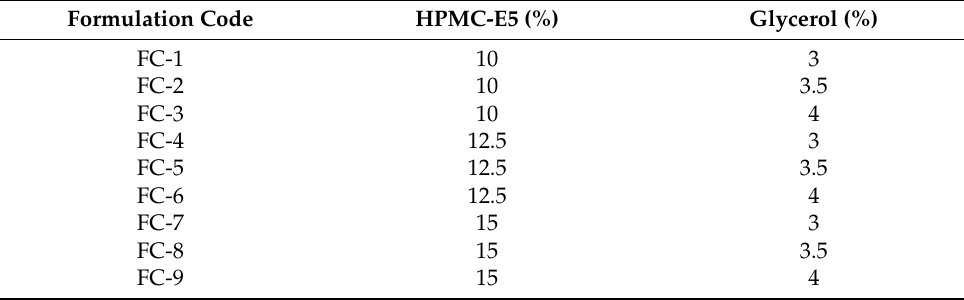
Figure 1. Schematic diagram of the manufacturing process of micelles-loaded orodispersible sublingual films. Table 2. Composition of micelle loaded orodispersible sublingual films of ebastine.